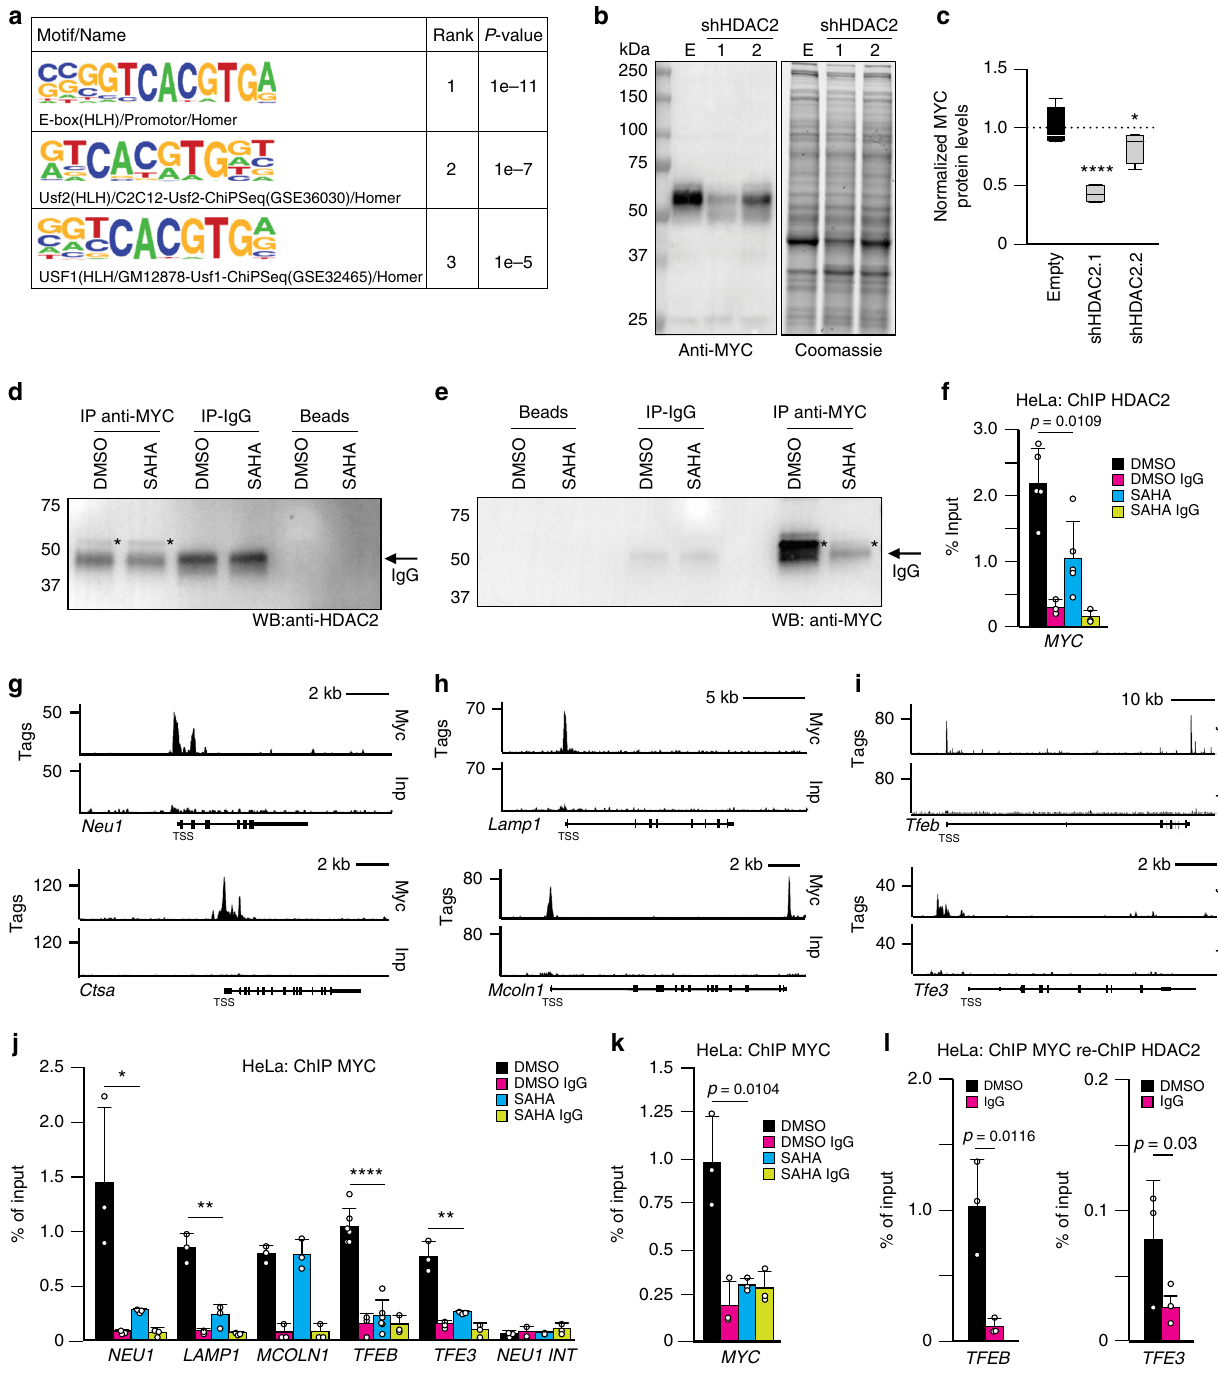
we observed a marked reduction in lysosomal gene expression (Fig. 3f, g) and reduced NEU1 activity (Fig. 3h) compared to WT MEFs. Together these results con fi rm that MIT/TFE members are indeed responsible for the activation of lysosomal genes after HDAC inhibition. biogenesis, we tested a set of mouse group 3 medulloblastoma cell lines overexpressing Myc 40,44 . In those cells, the expression of murine Mit/Tfe members was signi fi cantly downregulated, as was that of all tested lysosomal genes (Fig. 4a, b and Supplementary Data 2). The latter was accompanied by a reduction of the lysosomal volume (Supplementary Fig. 4l), decreased